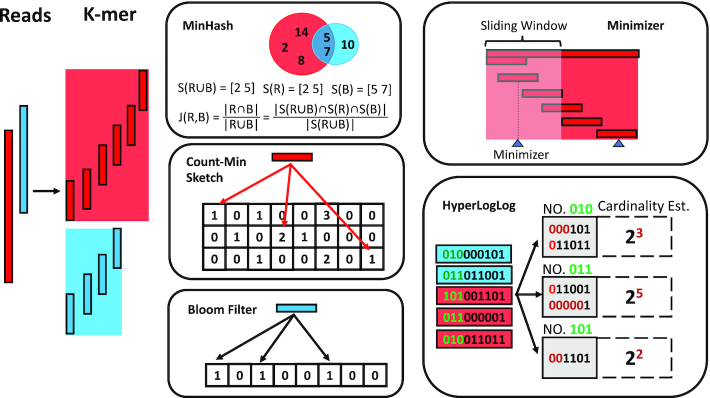
Important probabilistic algorithms and data structures. The sequences from two samples are decomposed into constituent k-mers. MinHash: each k-mer is hashed by a hash function and their hash values are stored in their corresponding hash sets R and B. MinHash sketch S(R) and S(B) with size s = 2 are shown. The Jaccard index between two hash sets is estimate by the fraction of hash values in the union of S(R) and S(B) (S(R∪B)) that are shared by both S(R) and S(B). Count-Min Sketch: three pairwise independent hash functions are applied to each k-mer. Each hash function is responsible for a row in the sketch and maps the hash values to the bins in its row. To encode an element into the sketch, the Count-Min sketch increases the numeric value in the mapped bins. To return the number of occurrences of a given k-mer, it hashes the k-mer using the same hash functions and returns the smallest value. Bloom filter: it initiates all the values in the array as 0. To record the presence of a k-mer in the dataset, it maps k-mer to the bits in the Bloom filter using three pairwise independent hash functions, and then it changes the mapped bits from 0 to 1. Minimizer: given a sequence, it can be compressed into a list of minimizers. To do that, a window slides across the sequence. In each window, the sequence inside the window is decomposed into k-mers. A minimizer is selected among the list of k-mers for the window at each position. HyperLogLog: each k-mer is represented by a hash value with length 9. The first three bits of a hash value is used to locate a register and the last 6 bits are saved in the corresponding register. The maximum number of leading zeros among all the values, that are stored in the register, is used to estimate the cardinality of each register.